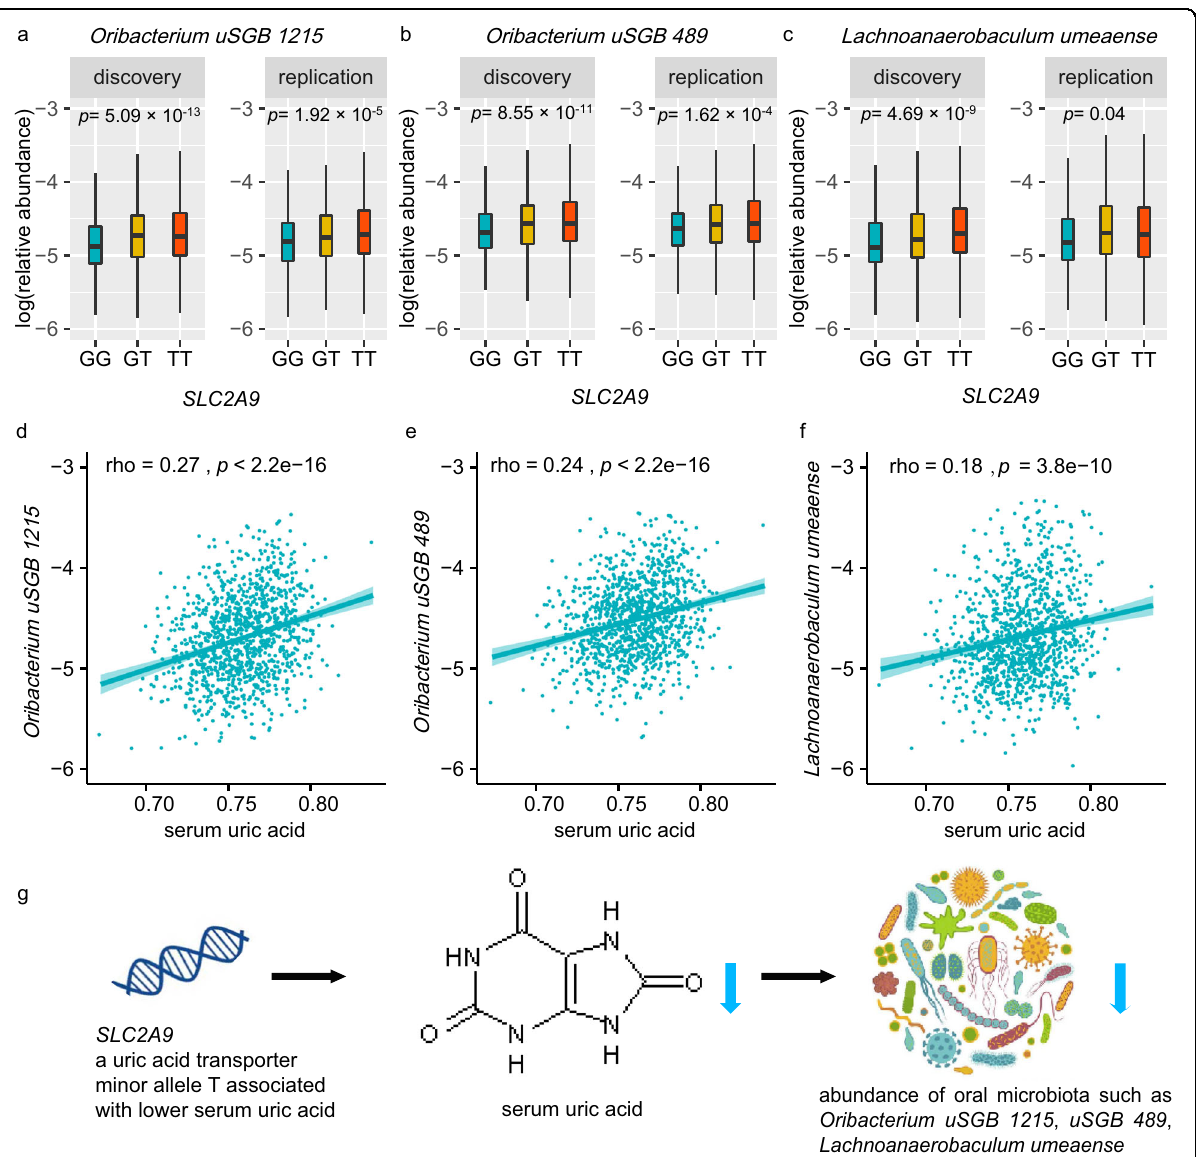
Fig. 3 Interaction of human SLC2A9 locus (rs3775944), serum uric acid, and three tongue dorsum bacteria. a – c The three panels present the associations of SLC2A9 variation with microbial abundances of the three most signi fi cantly associated taxa: Oribacterium uSGB 1215 , Oribacterium uSGB 489 , and L. umeaense ), which reached study-wide signi fi cance in the discovery ( n = 2017) cohort and were well replicated in the replication ( n = 1333) cohort. d – f Correlations between three tongue dorsum bacteria and serum uric acid. Spearman ’ s correlation coef fi cient (rho) and p value were shown. g Schematic representation of the interaction among SLC2A9 locus (rs3775944), serum uric acid, and three tongue dorsum bacteria: SLC2A9 as a uric acid transporter, its minor allele T of SNP rs3775944 associated with lower serum uric acid, and genetic predisposition to lower serum uric acid level is associated with lower abundance of Oribacterium uSGB 1215 , Oribacterium uSGB 489 , and Lachnoanaerobaculum umeaense